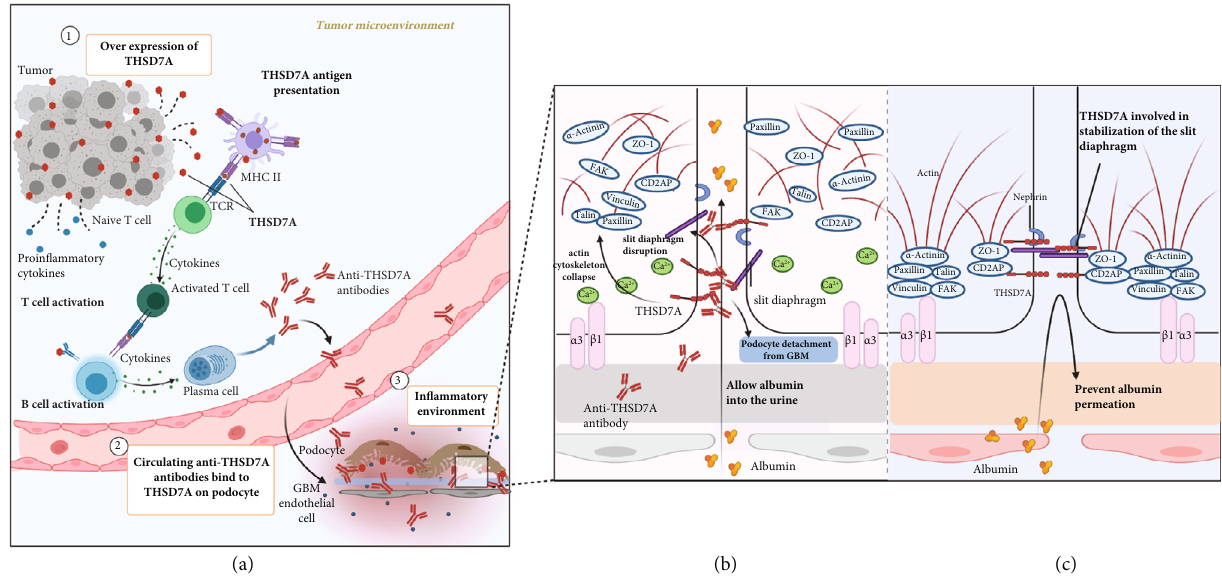
Figure 3: The hypothetical pathogenesis model of PM2.5-associated idiopathic membranous nephropathy (iMN). (a) PM2.5 induces extrarenal anti-PLA2R antibody production. Inhalation of PM2.5 results in the accumulation and activation of alveoli macrophages and neutrophils. PLA2R that is presented on these cells can be discharged into the in fl ammatory space, when neutrophil extracellular traps (NETs) and macrophage extracellular traps (METs) are released. In fl ammation enhances the immunogenicity of the autoantigen and a ff ects the antigen processing capacity of antigen-presenting cells (APCs), which contributes to the autoimmune response. We hypothesize that the PLA2R antigen may be captured by mature APCs, which become accessible producing anti-PLA2R antibodies. (b) The in situ immune complexes are initiated by binding of extrarenal anti-PLA2R antibodies to endogenous PLA2R in the glomeruli. PM2.5 can also cause renal injury and alter renal microenvironment, which may a ff ect the molecular conformation of PLA2R antigen on the podocytes that is necessary for anti-PLA2R antibodies to bind. Abbreviations: GBM: glomerular basement